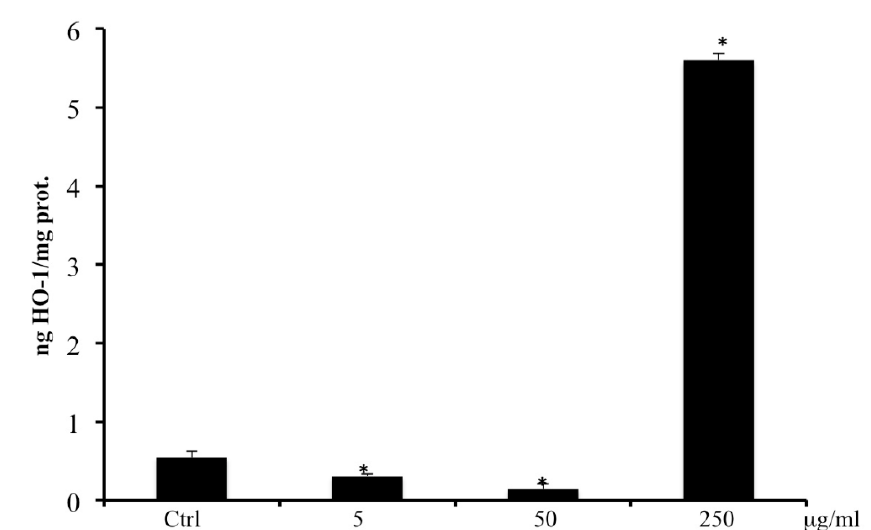
Figure 7. Heme oxygenase-1 (HO-1) levels in CaCo2 cells untreated and treated for 72 h with methanolic extract of B. etnensis Raf. at different concentrations (5–250 µg/mL). Values are the mean ± SD of four experiments in triplicate. *Significant vs. untreated control cells: p < 0.001.